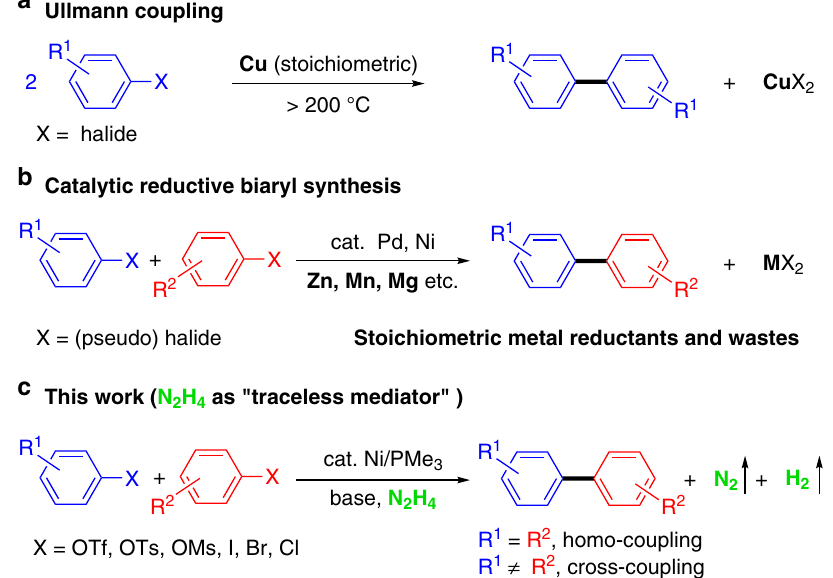
Fig. 1 Reductive homo- and cross-coupling of aryl electrophiles to synthesize biaryl structures. a Traditional Ullmann coupling with stoichiometric copper under high temperature; b Pd or Ni catalyzed Ullmann coupling with stoichiometric metals and wastes; c N 2 H 4 as traceless mediator for homo- and cross- aryl